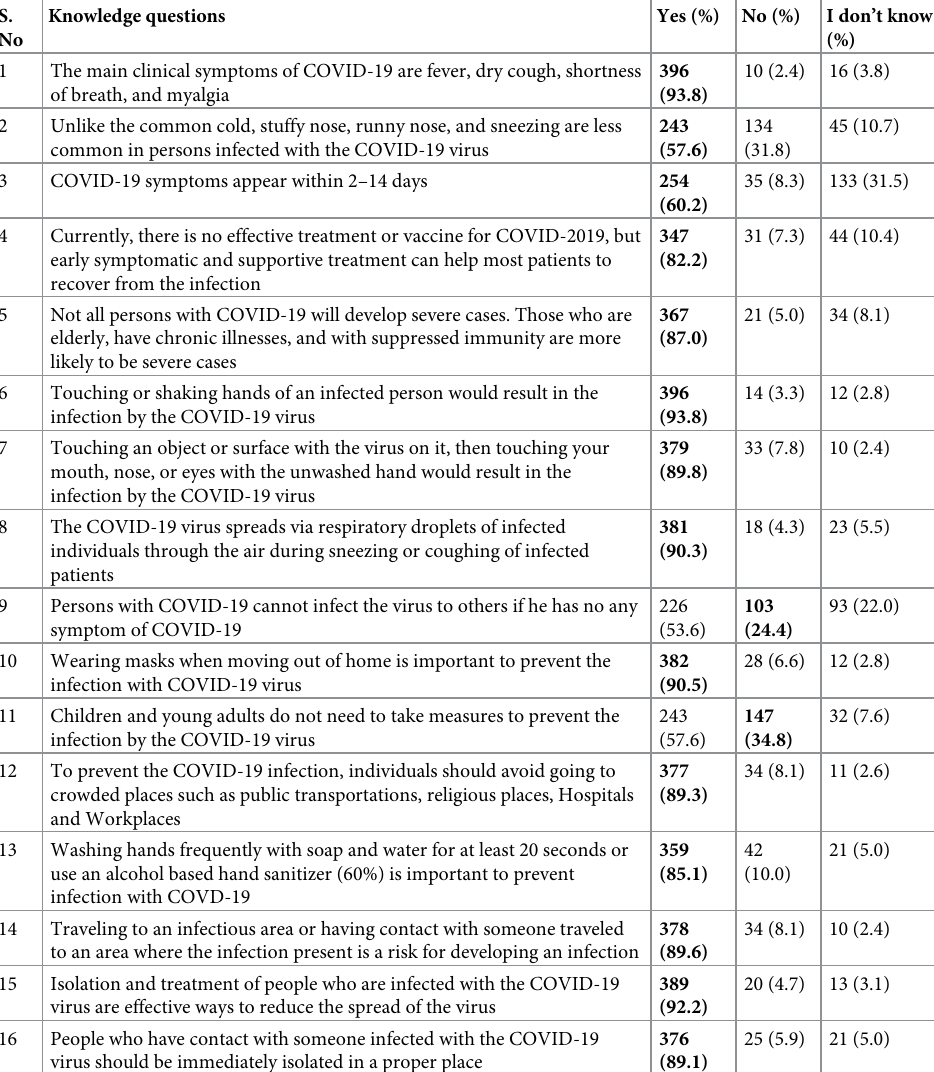
Table 2. Knowledge about COVID-19 among chronic disease patients at selected public hospitals of Sidama regional state, Ethiopia, 2020 (N = 422)]. S. Knowledge No